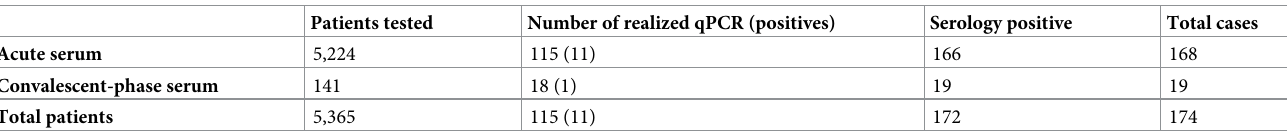
Table 1. Rickettsia typhi results of serology and PCR